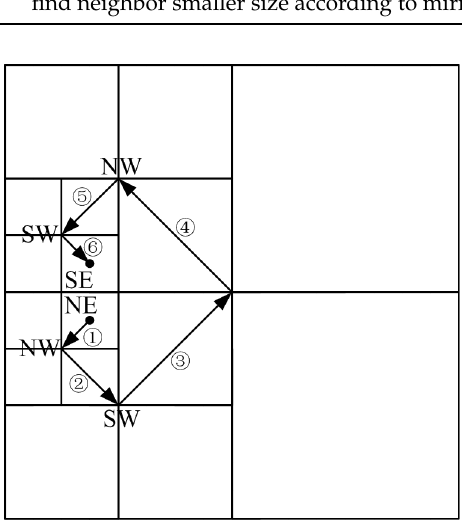
Figure 3. Neighbor finding () algorithm.